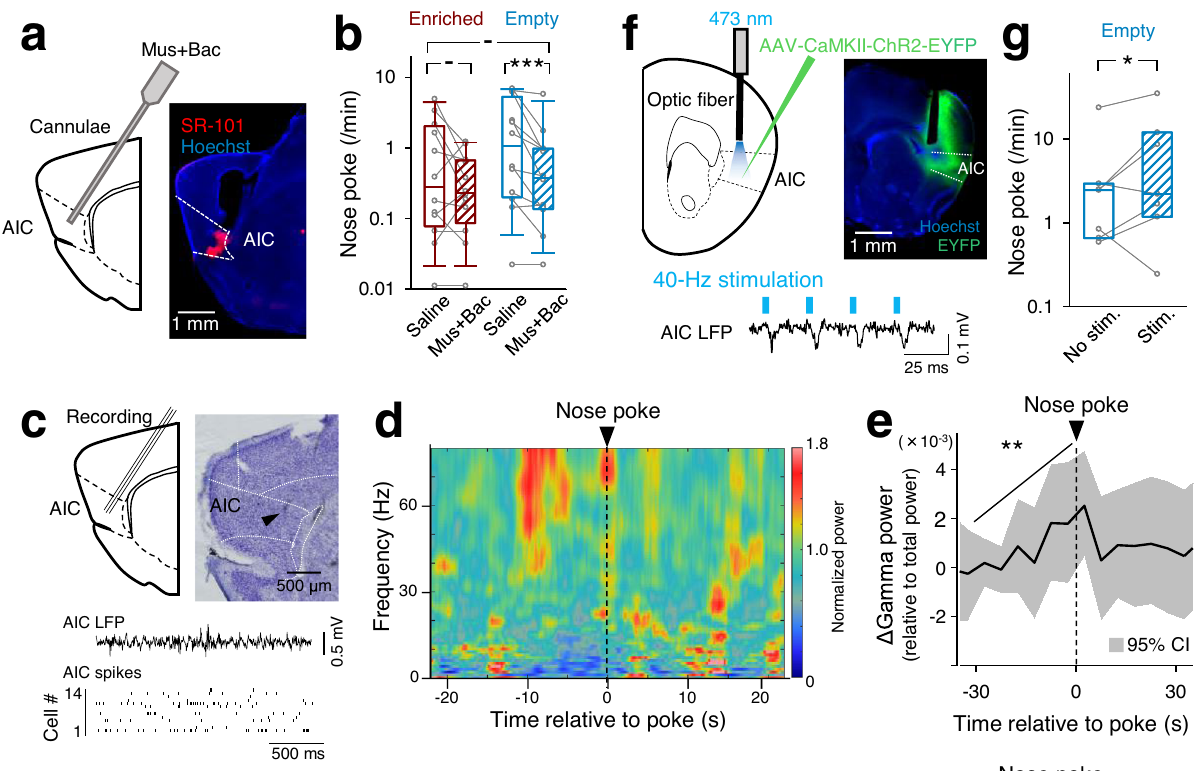
Fig. 2 | Gamma oscillations in the AIC increase before nose-poking behavior. a Muscimol and baclofen (Mus+Bac) were injected into the AIC together with the fl uorescent dye SR-101, by which the tip of cannulas for drug injection was con- fi rmed post hoc . Similar macrographs were obtained from independent experi- ments performed on 12 mice. b The frequencies of nose pokes in enriched and emptychamberswerecomparedbetweenmicetreatedwithsalineorMus+Bac.The box plots indicate the median, interquartile range, and extreme values. - P >0.17, *** P <0.0001, n =12 mice, two-sided paired bootstrap test with Bonferroni correc- tion. c Extracellular recording from the AIC. The arrowhead indicates the location oftheelectrodetip.Thebottompaneldemonstratesarepresentativetraceoflocal fi eld potentials (LFPs) and a raster plot of spikes of 14 simultaneously recorded neurons. Similar macrographs were obtained from independent experiments